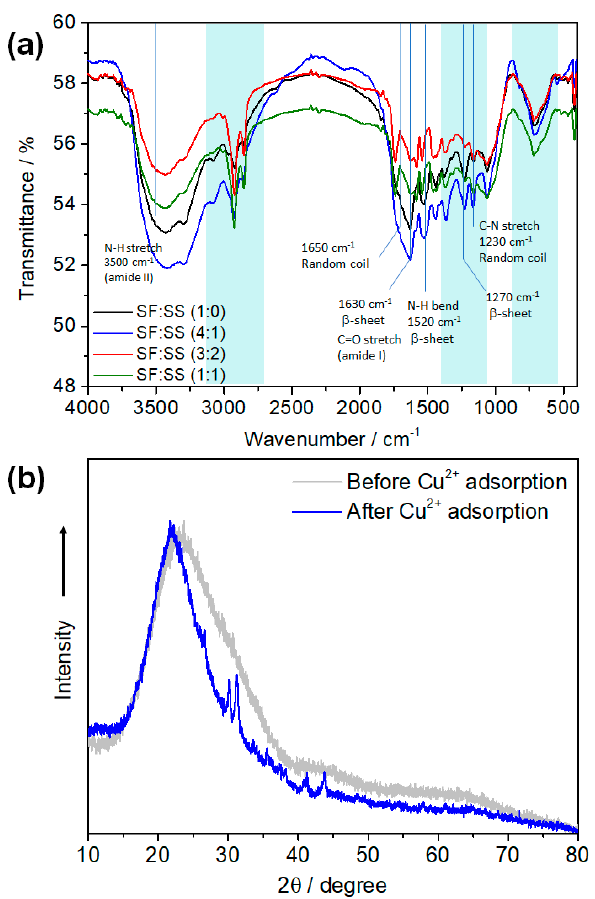
Figure 8. ( a ) FTIR spectra of SF:SS with different compositions after Cu 2+ adsorption and ( b ) XRD spectra of SF:SS (4:1) before and after Cu 2+ adsorption.